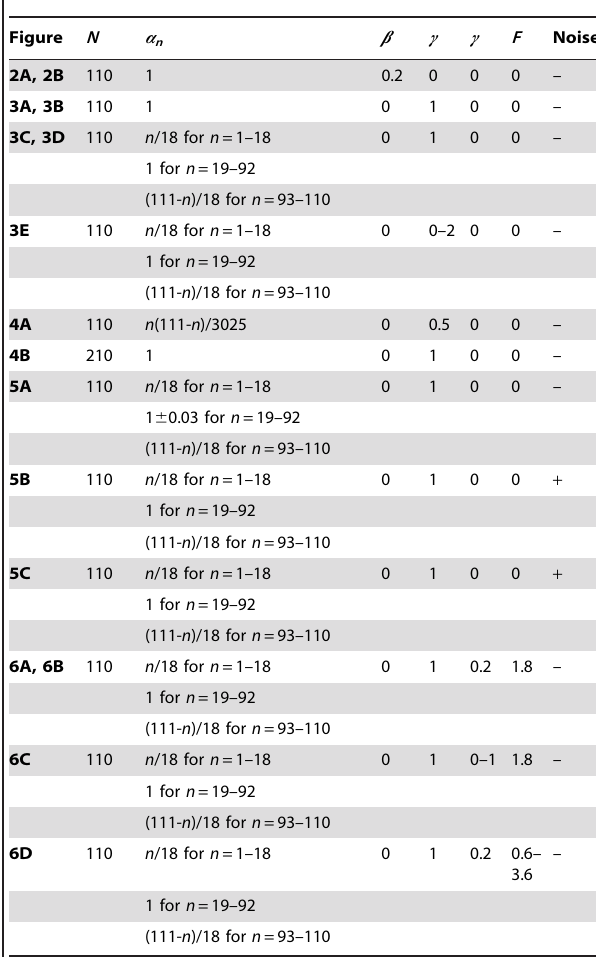
Table 1. Parameter values for simulations.